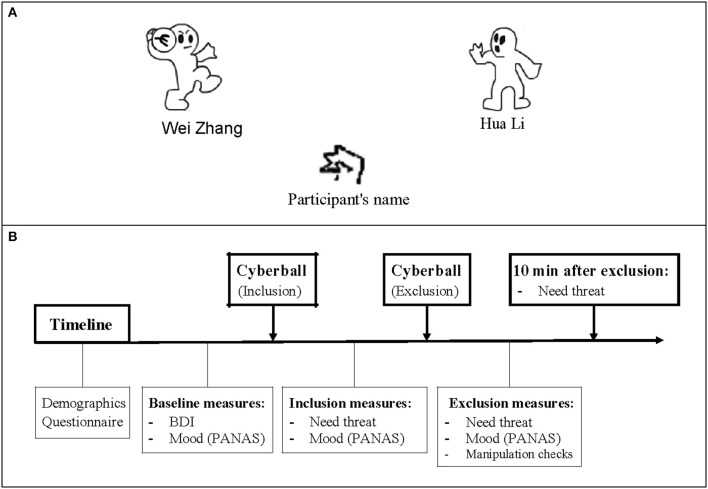
The Cyberball game and a schematic of the experiment program. (A) The Cyberball game: Participants are represented by a cartoon of hand at the bottom of the screen, and computer-generated players stand on either side. During the inclusion block, participant has a 50% chance of receiving the ball at each throw. While in exclusion condition, participant cannot catch the ball after receiving 10 throws. (B) A schematic of the time course of the experiment. After completing the demographics and basic measures, participant was asked to play the Cyberball game and report how they felt about the game. 10 min after the exclusion block, the Need-Threat Scale (NTS) was retested.